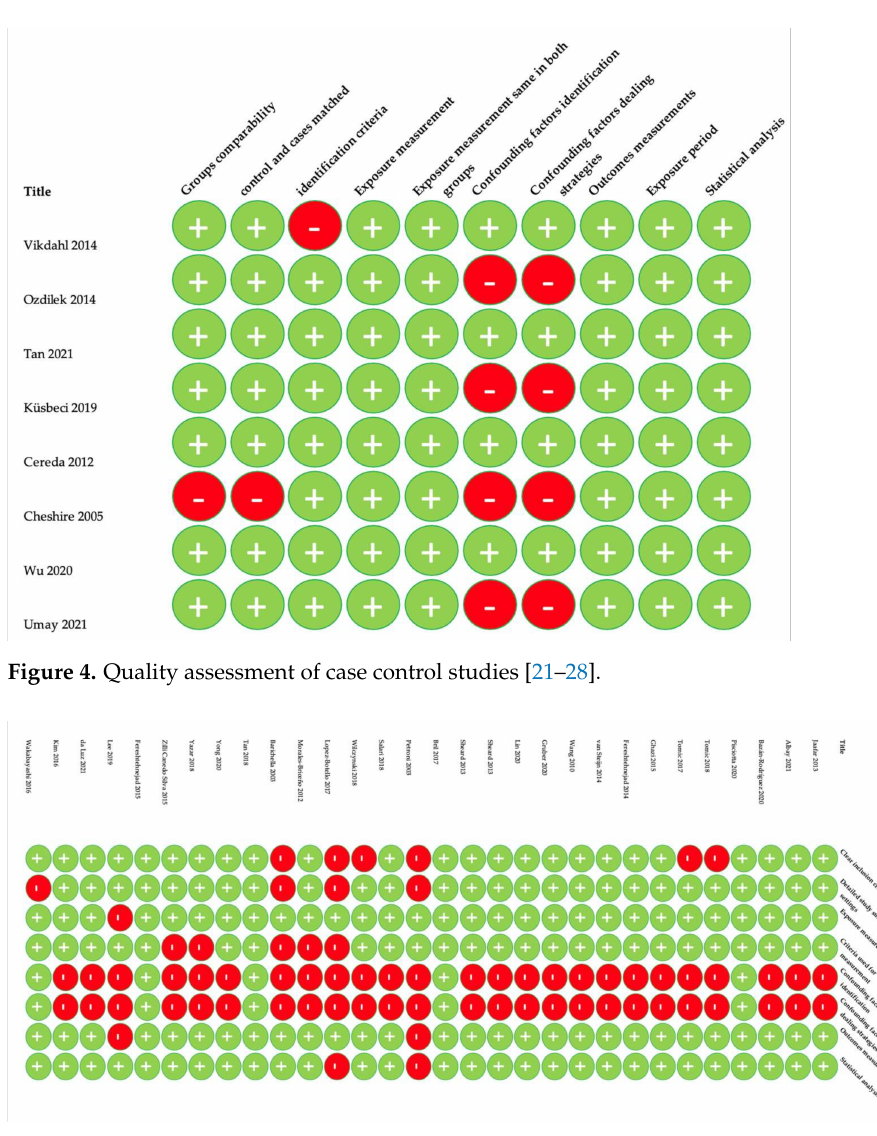
Figure 5. Quality assessment of cross-sectional studies